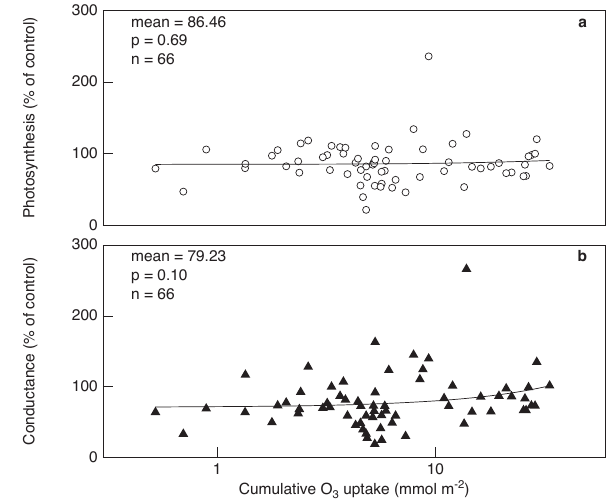
Fig. 4. The correlation between cumulative O 3 uptake (CUO) and photosynthesis (open symbols; a ) or stomatal conductance (closed symbols; b ) in all data that is compared to control plants exposed to charcoal-filtered air where CUO values were reported in the publi- cation (e.g., high-confidence